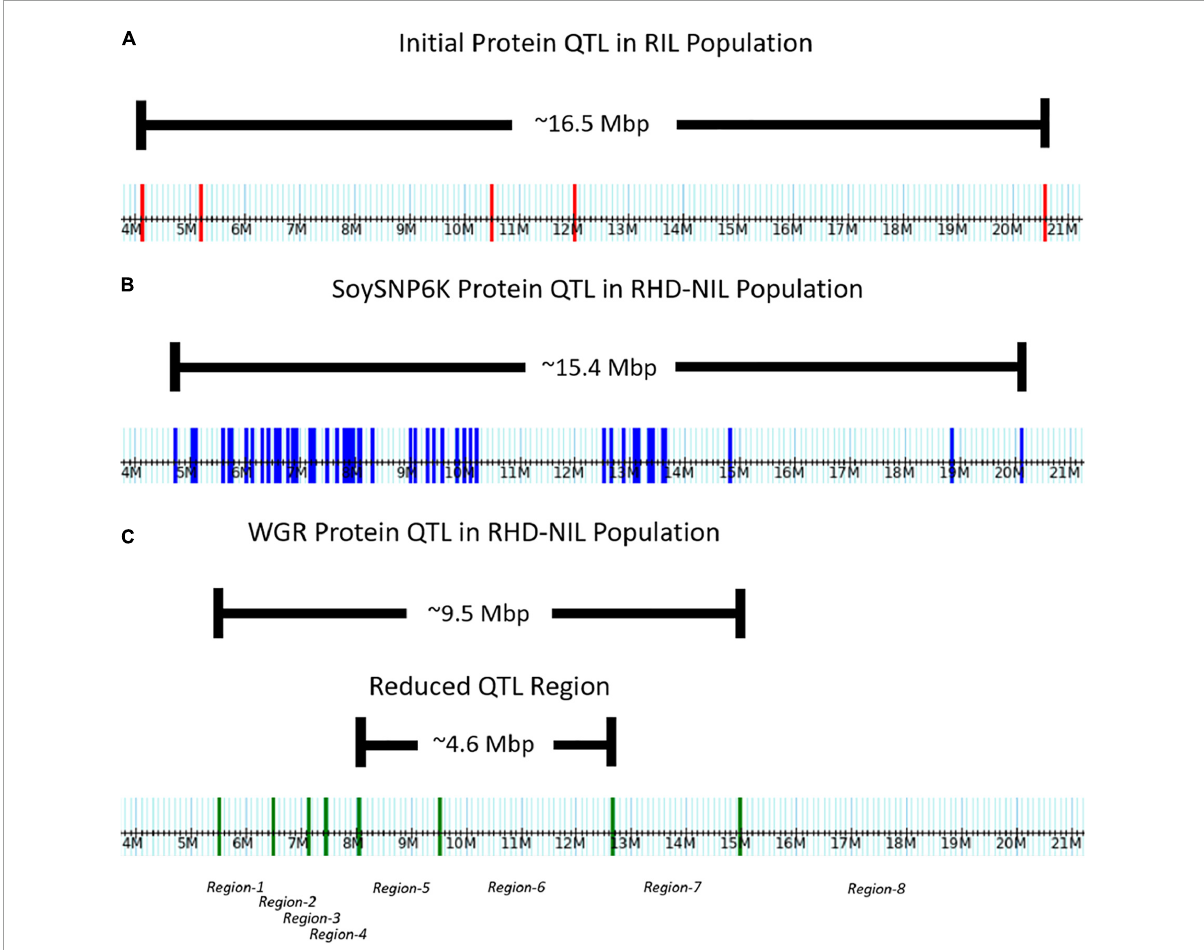
FIGURE3 Distribution of markers across the Chr.14 protein QTL on the physical map. (A) Five genotyping-by-sequencing (GBS) markers in the initial RIL population. (B) Fifty-one SoySNP6K markers in the RHD-NIL population. (C) Eight WGR markers in the RHD-NIL population. The eight recombination regions are indicated on the physical